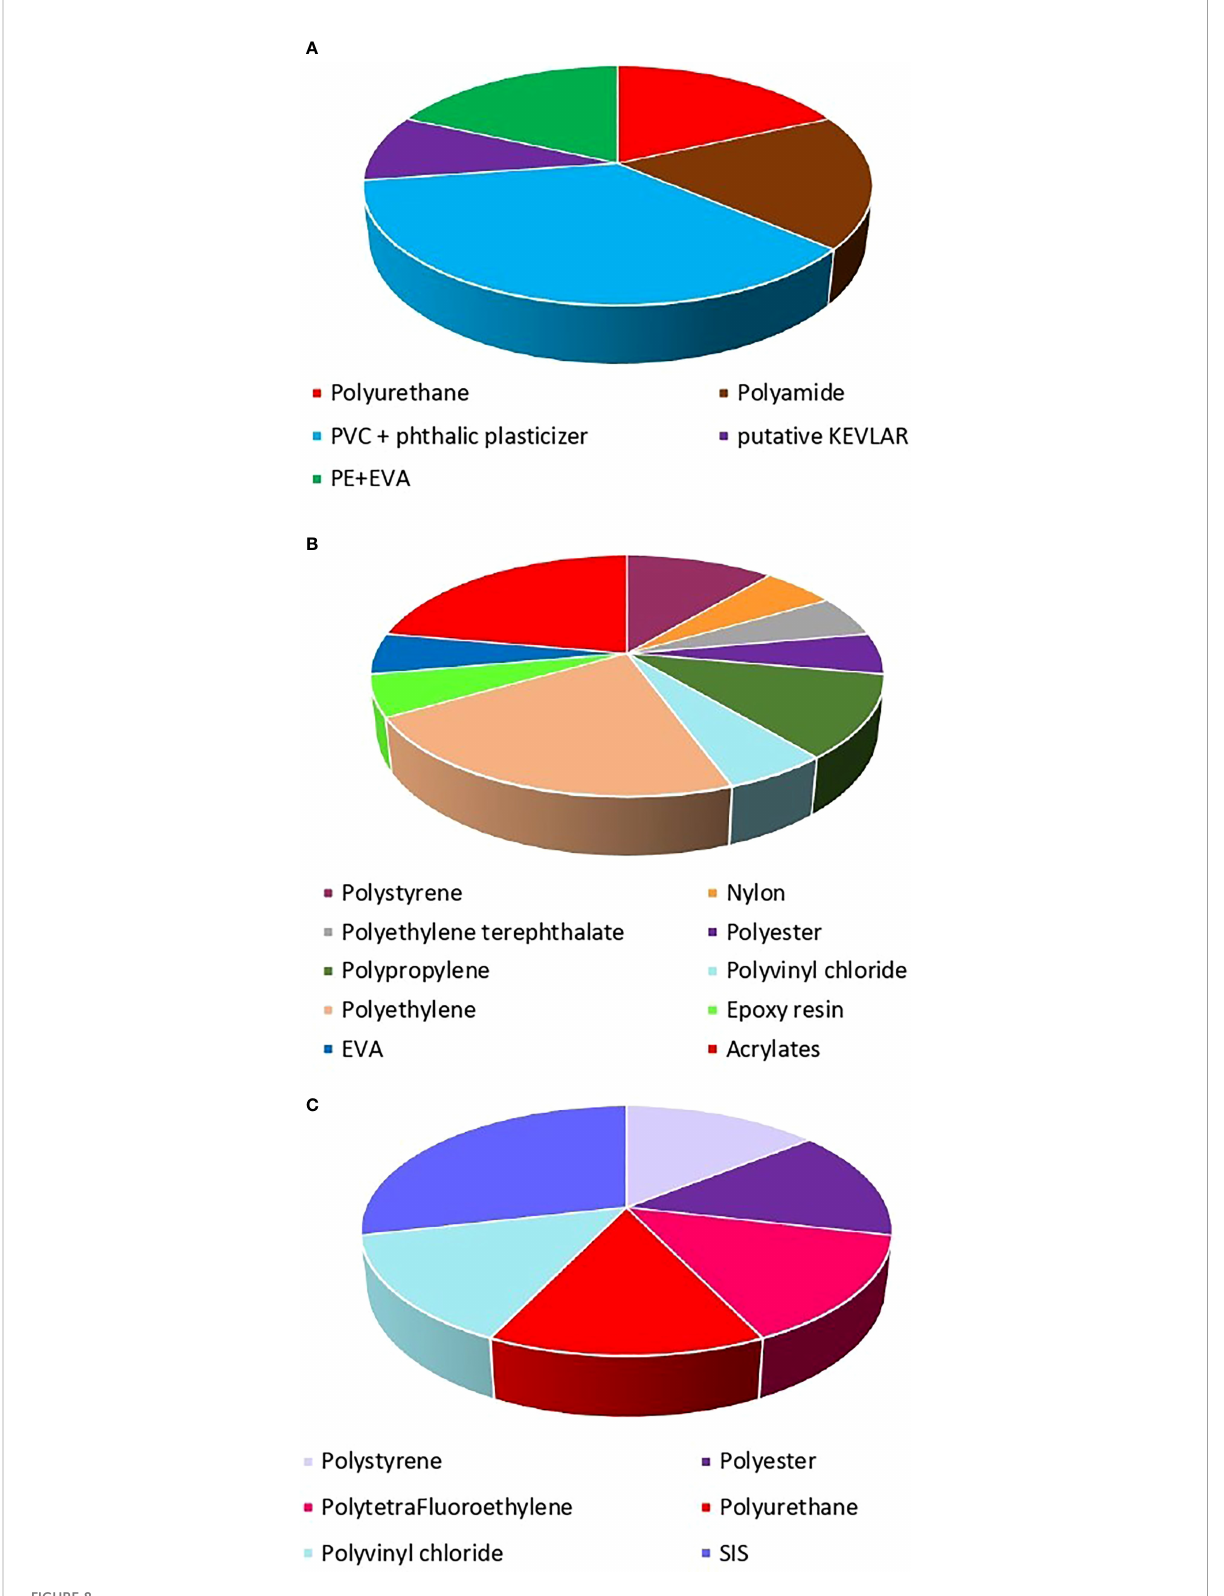
FIGURE 8 Polymeric composition of microplastics in the deep-sediments at (A) 221 m, (B) 304 m and (C) 910 m in San Gregorio